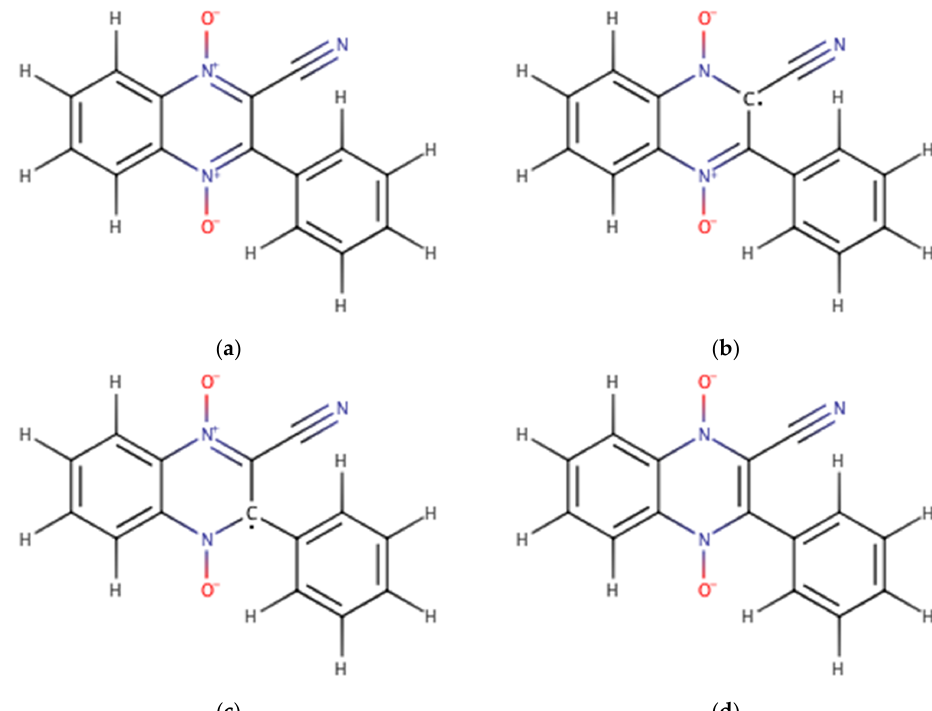
Figure 1. The individual structures for molecule A1: ( a ) the neutral molecule; ( b ) the possible anion product from Wave 1 with the radical on C2 ( c ) the possible anion product of Wave 1 with the radical on C3; and ( d ) the dianion product of Wave 2. Chemical structures drawn in MarvinSketch [20]. For the derivatives containing the nitro group (E1–E4), six (6) structures were created: the original neutral molecules, two (2) possible anion products from Wave 1, two (2) possible dianion products from the nitro group reduction (Nitro Wave), and the trianion product at the end of Wave 2. Figure 2 shows 2D structures created with MarvinSketch for each of the six (6) individual structures for molecule E1 [20]. The original neutral molecule is shown in Figure 2a. The two (2) possible structures for the product of Wave 1 have the radical assigned either to the C2, the carbon adjacent to either the nitrile group, (Figure 2b) or to C3, the carbon adjacent to the aryl group, (Figure 2c). The two (2) possible products following the Nitro Wave results in a one radical electron on the nitro group and one radical electron on either the C2 (Figure 2d) or C3 (Figure 2e). The trianion structure following Wave 2 is shown in Figure 2f. Figure A2 in Appendix A shows the 3D structures optimized in Gaussian 09 for the same six (6) individual structures of E1.